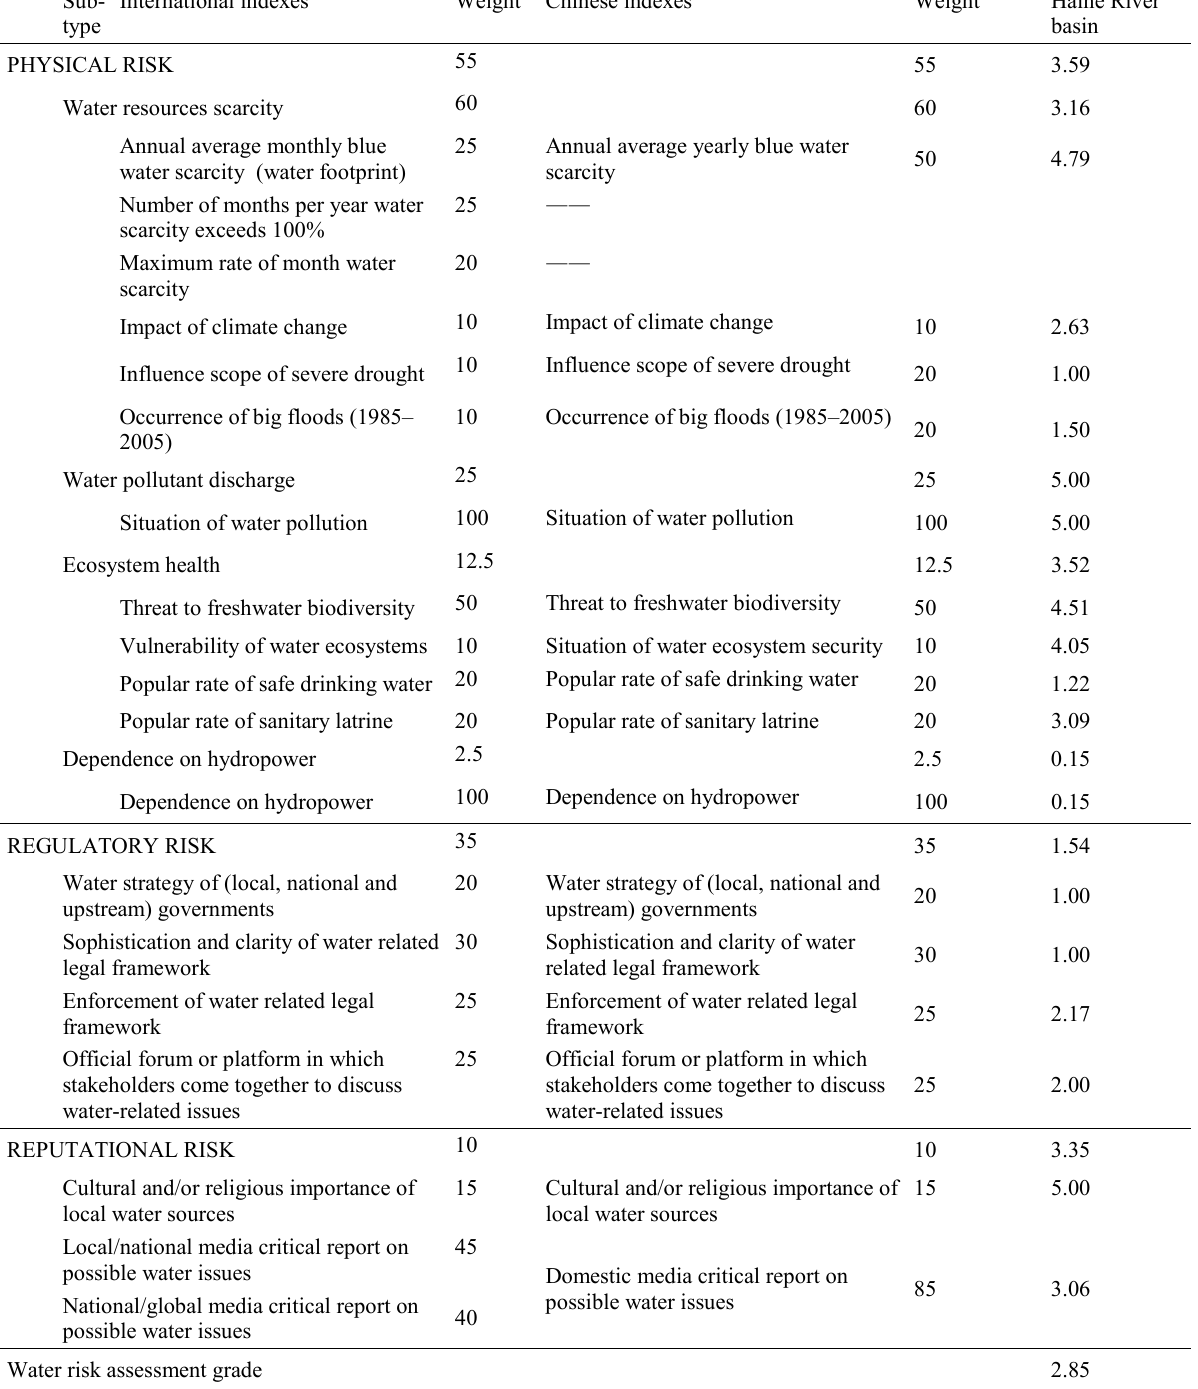
Table 4 Index weights for water risk assessment, and assessment for Haihe River